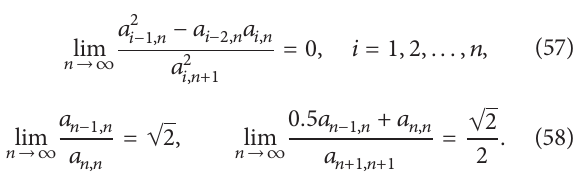
(solid line), the cubic trigonometric curve (dashed line), and with node expression (48),